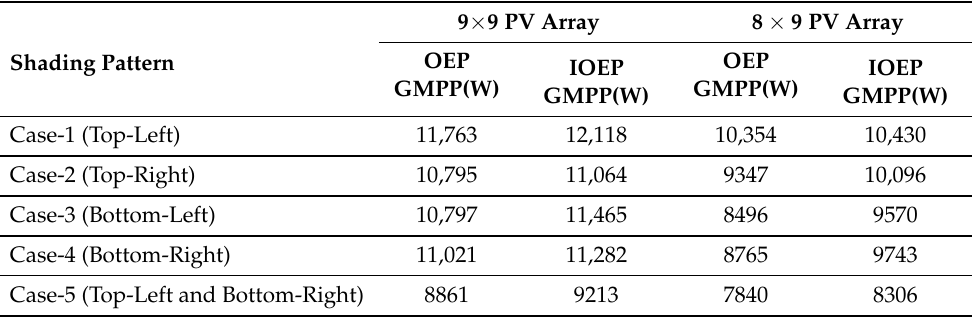
Table 7. GMPP for 9 × 9 and 8 × 9 PV array for different shading patterns.